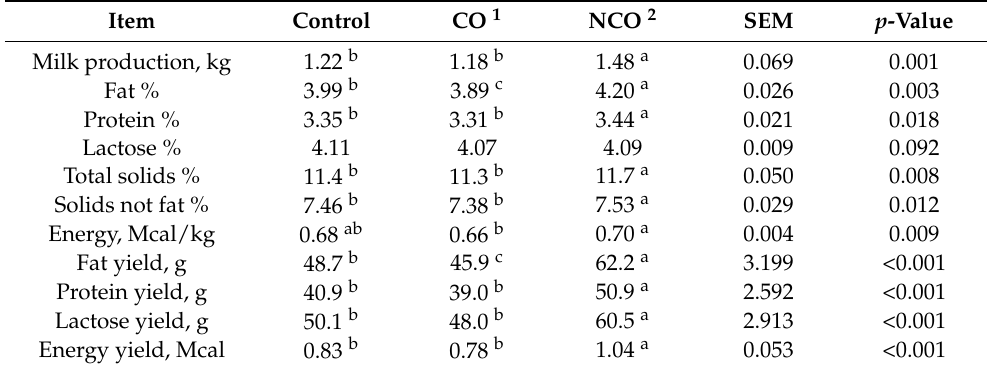
Table 4. Effect of the supplementation of raw and nanoemulsified corn oil on the milk production and composition of dairy goats.